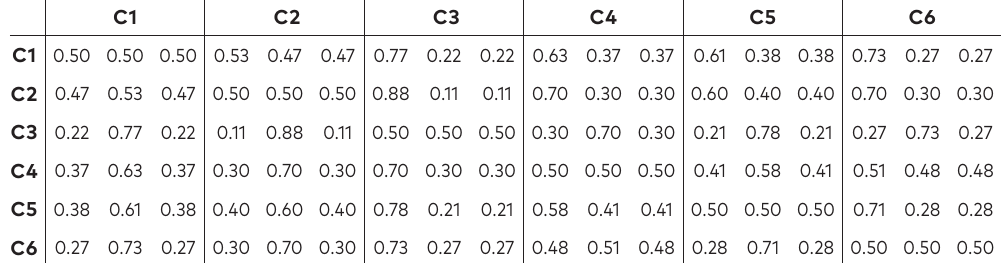
Table 6. The aggregated